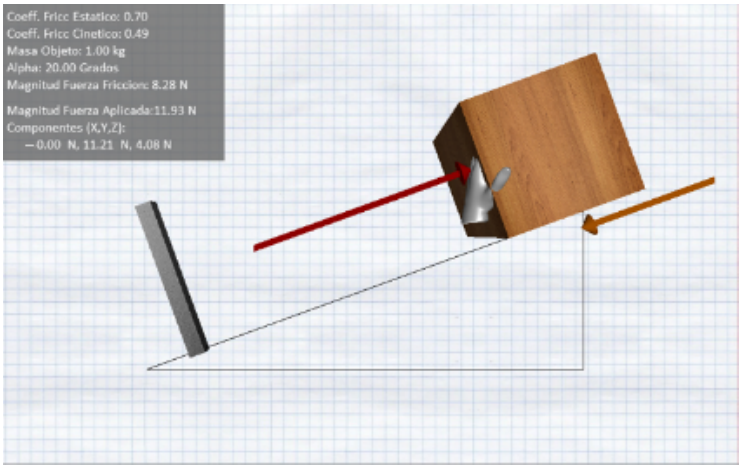
Figure 5. Interface elements of the “block on a rough incline” visuo-haptic environment developed with Chai